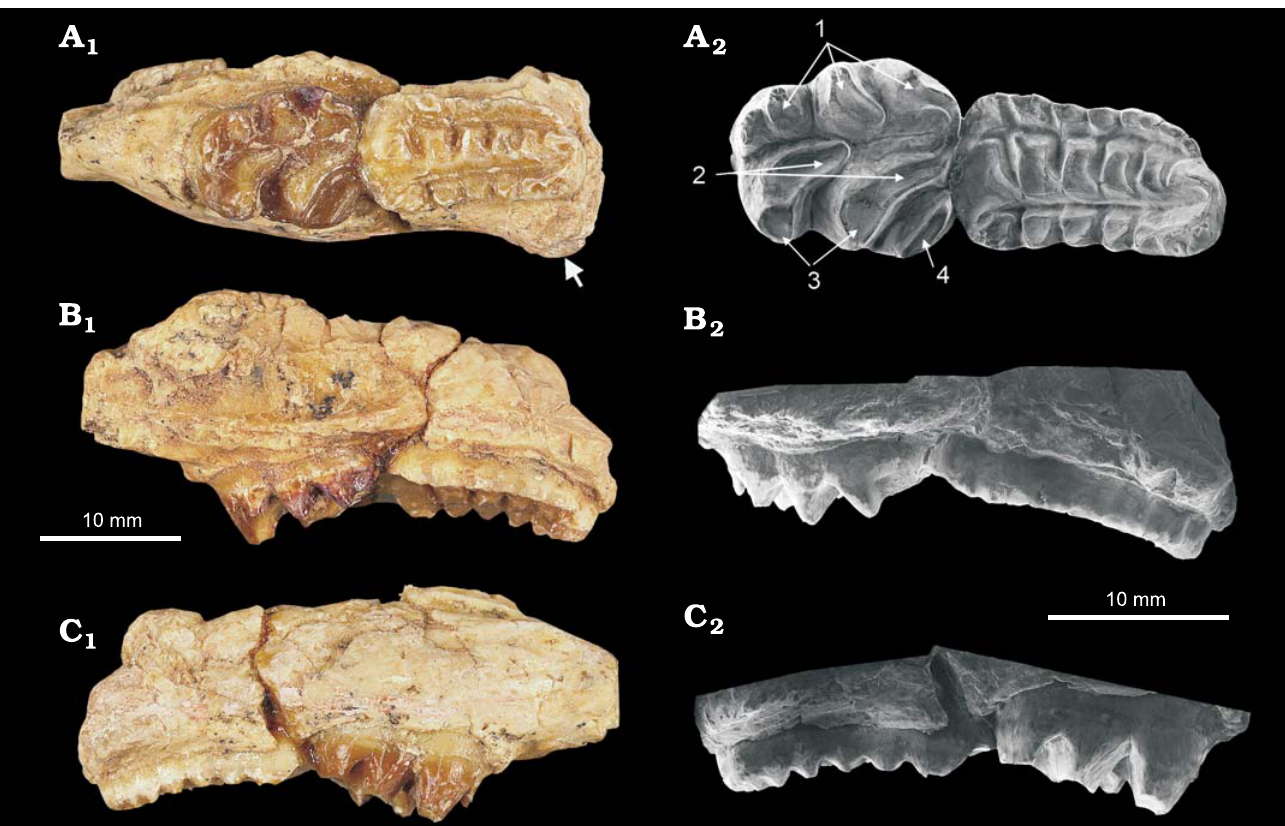
Fig. 4. Multituberculate mammal Sphenopsalis nobilis Matthew, Granger, and Simpson, 1928 (IVPP V19025) from the upper Paleocene Nomogen beds at the Erden (Urtyn) Obo locality, Inner Mongolia, China. Partial left maxilla with M1 and M2 in occlusal ( A ), medial ( B ), and lateral ( C ) views. The arrow indicates the broken anterior root of the zygomatic arch; wear facets: 1, on buccal sides of the lingual cusps of M2; 2, on lingual sides of the medial cusps of M2; 3, on buccal sides of the medial cusps of M2; 4, on the cusp of the buccal (external) row, which is aligned with the buccal wear facets of